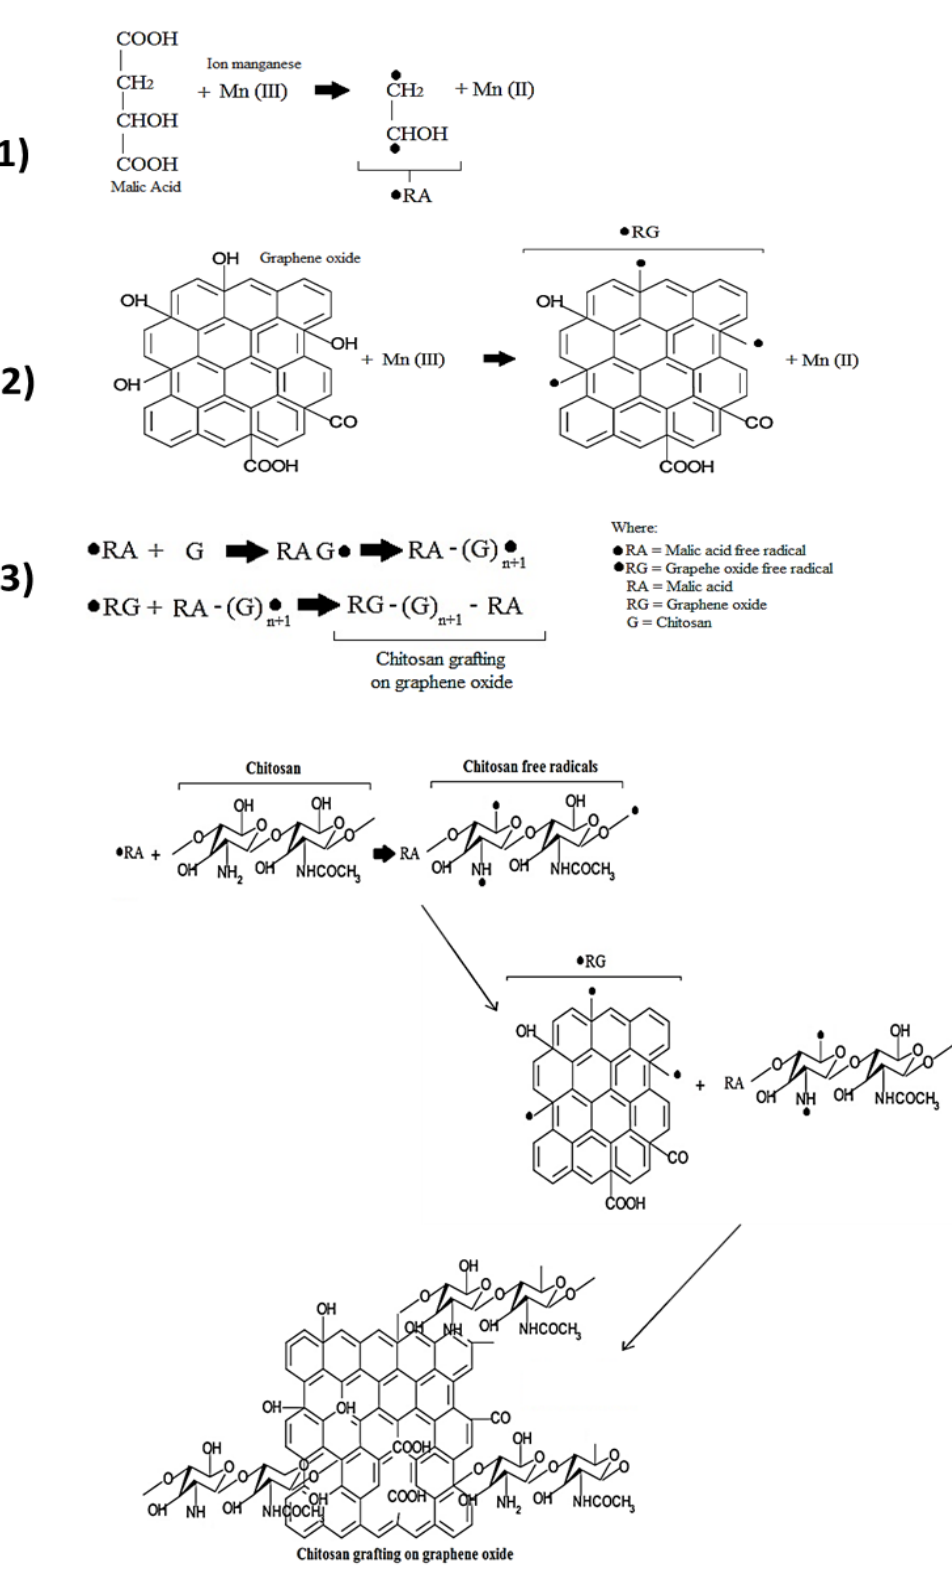
Figure 6. Reaction scheme of chitosan grafting onto graphene